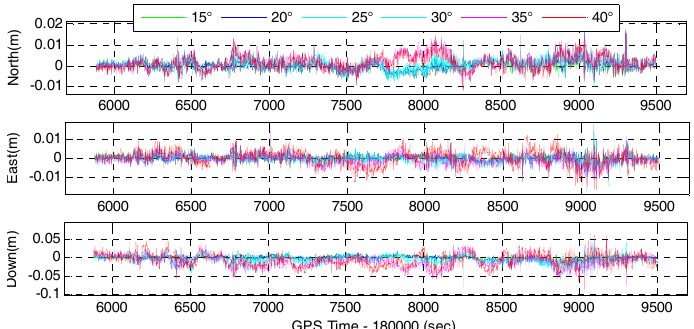
Figure 15. Position difference of GPS/BDS/INS with elevation cut-off angles of 15, 20, 25, 30, 35 and 40°.